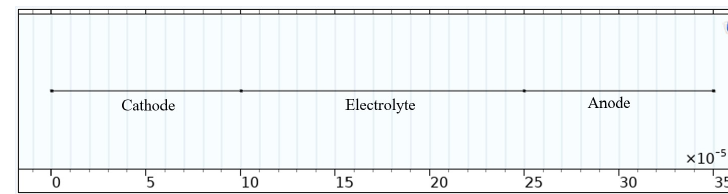
Figure 3. Planar cylindrical geometry in 1D space.